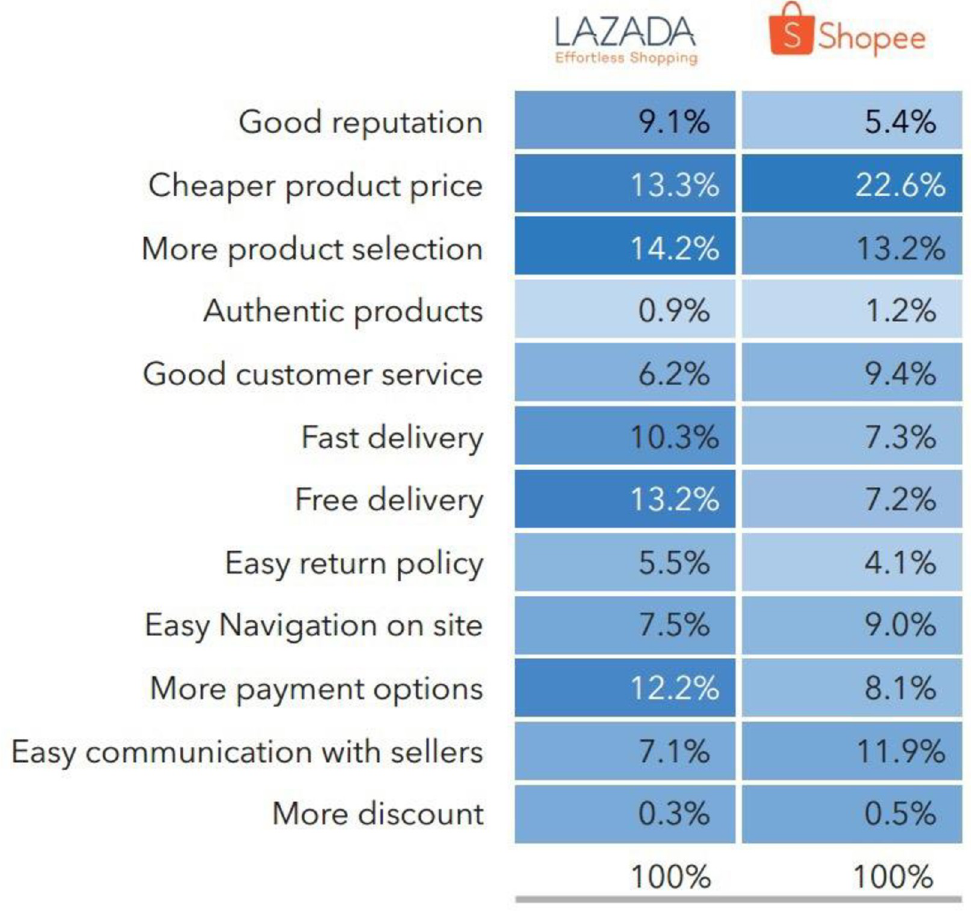
Fig 3. What shoppers like about their favourite e-marketplace, Cite from (aCommerce